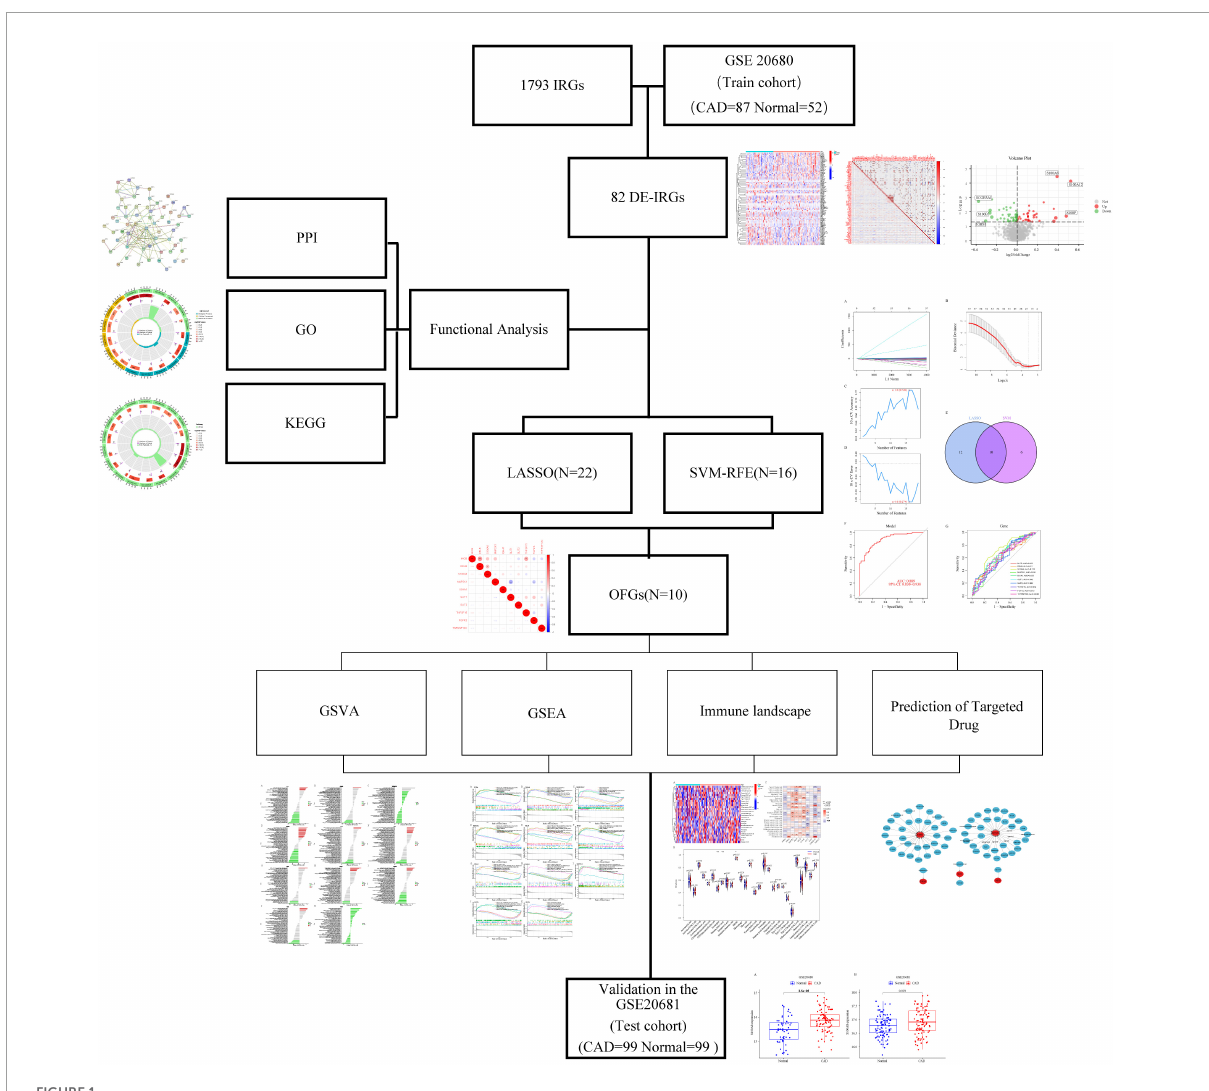
FIGURE1 The network of this